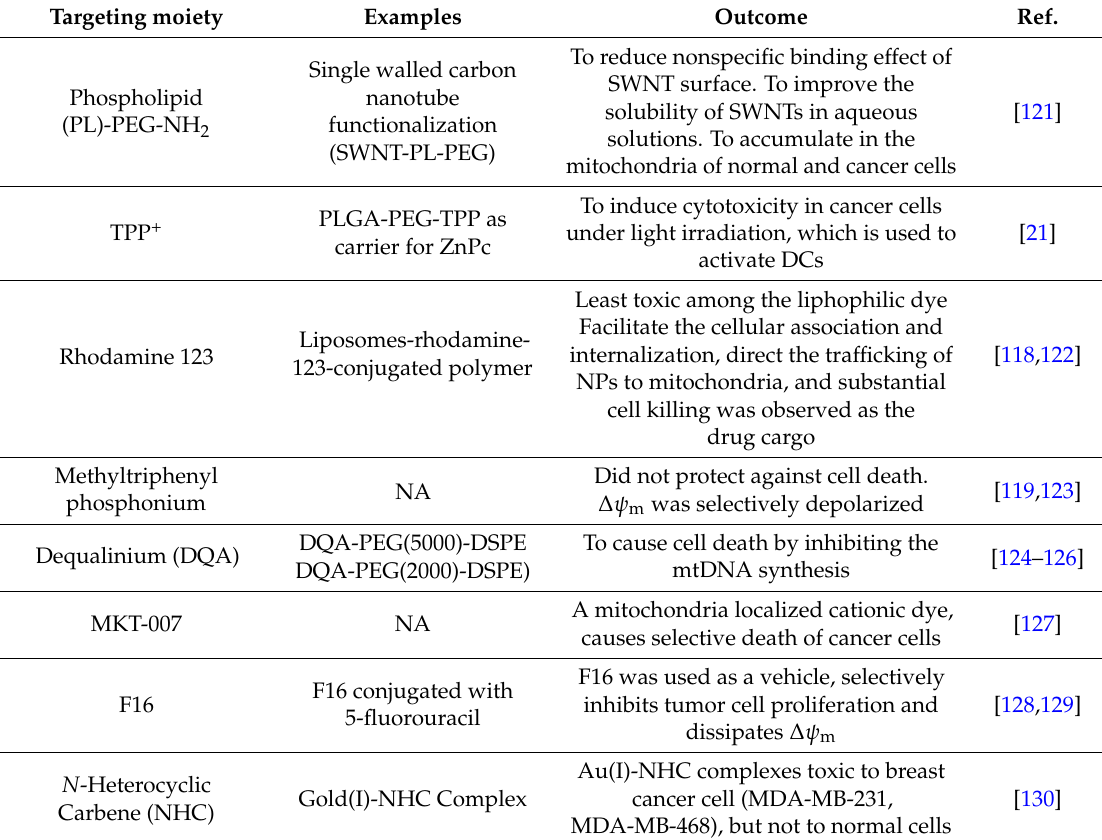
Table 5. Summary of the lipophilic cations as mitochondria targeting moiety. Targeting